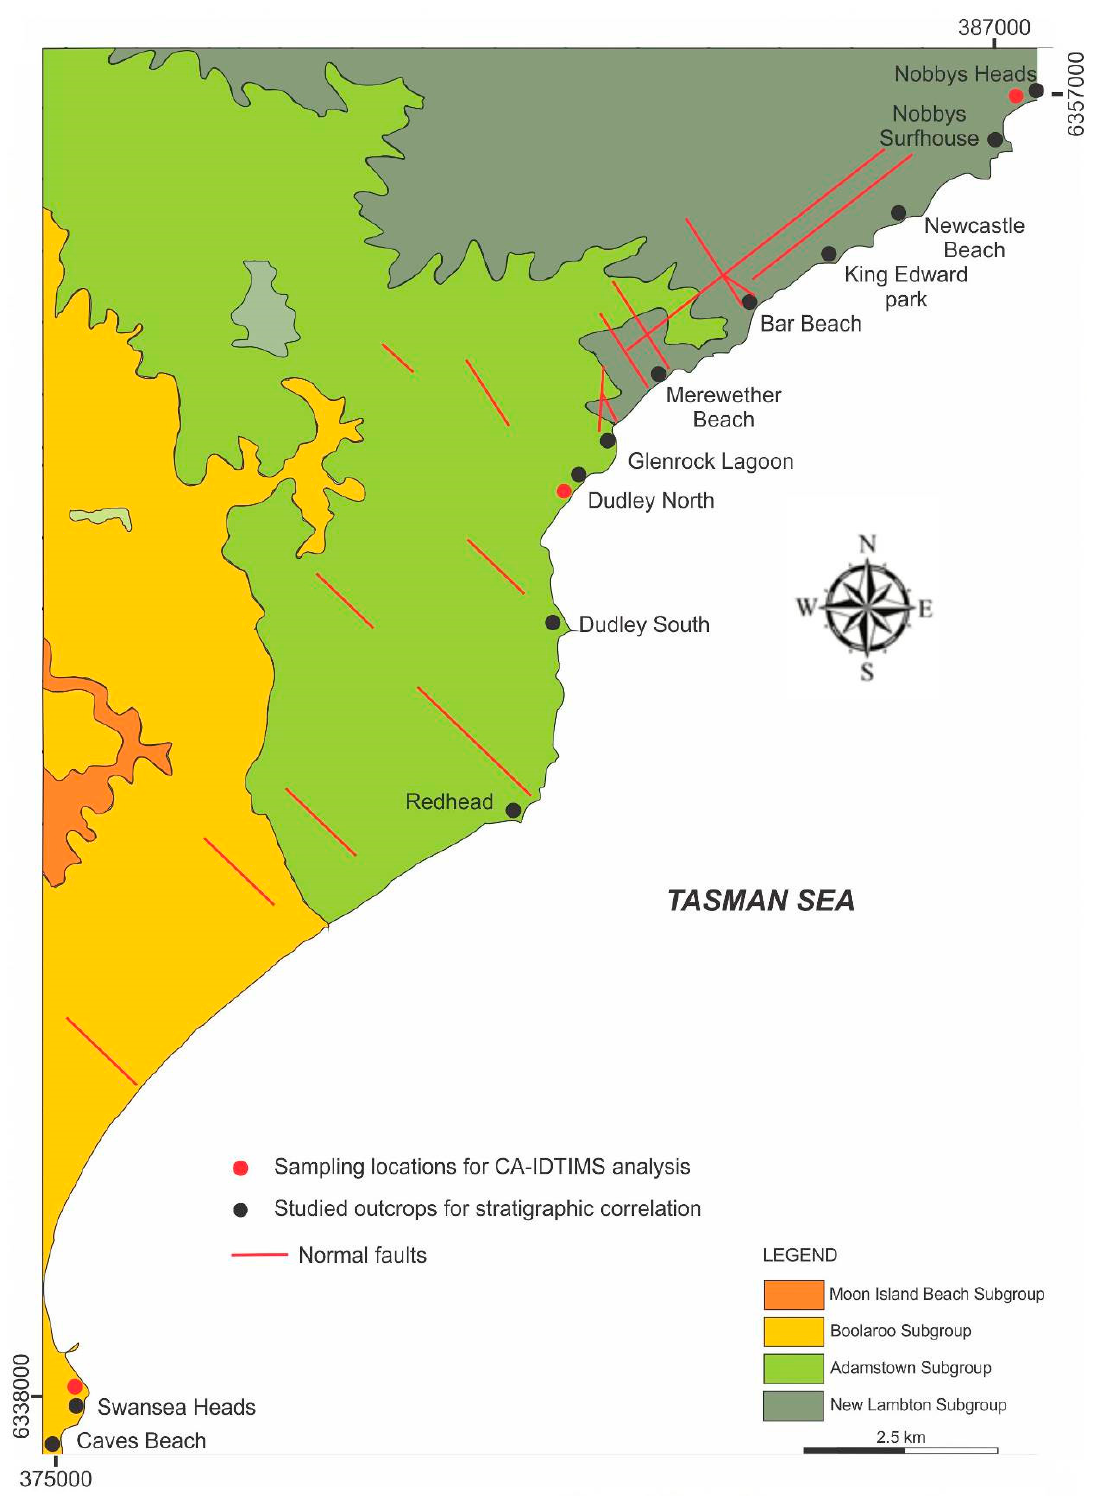
Figure 4. Map of the study region illustrating the lateral extension of the different sub-groups. Black dots refer to the selected locations for geochemical analysis, red dots to the locations for CA-IDTIMS analysis.